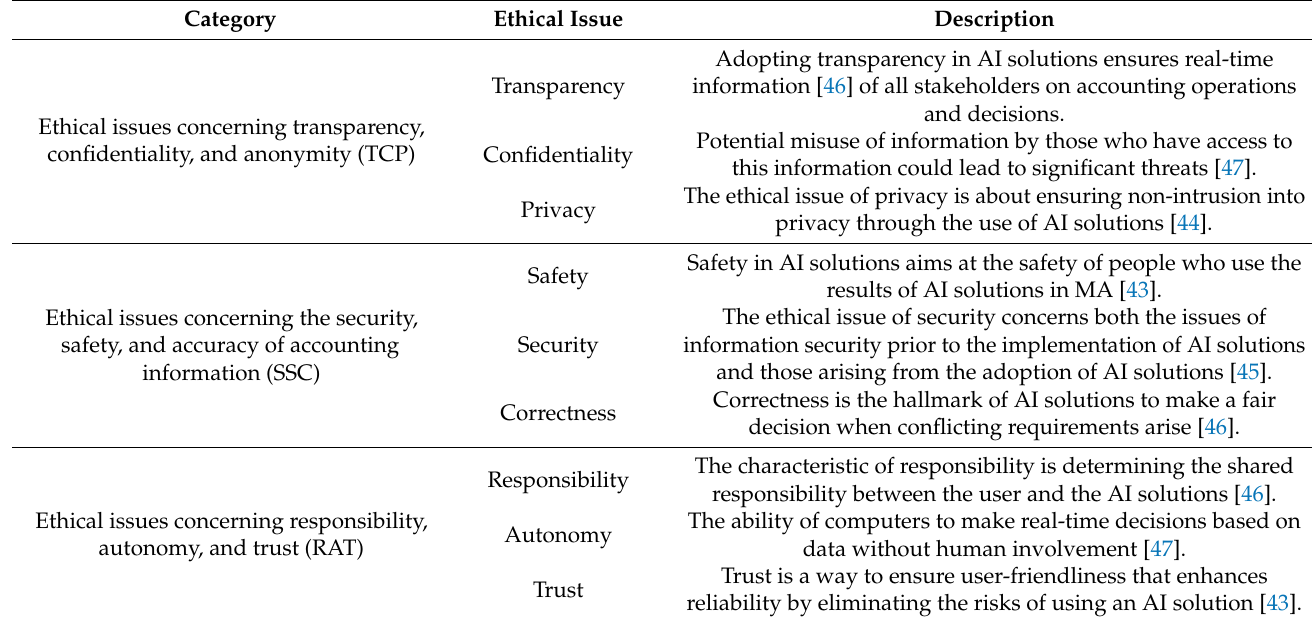
Table 1. Grouping the ethical issues of using AI in